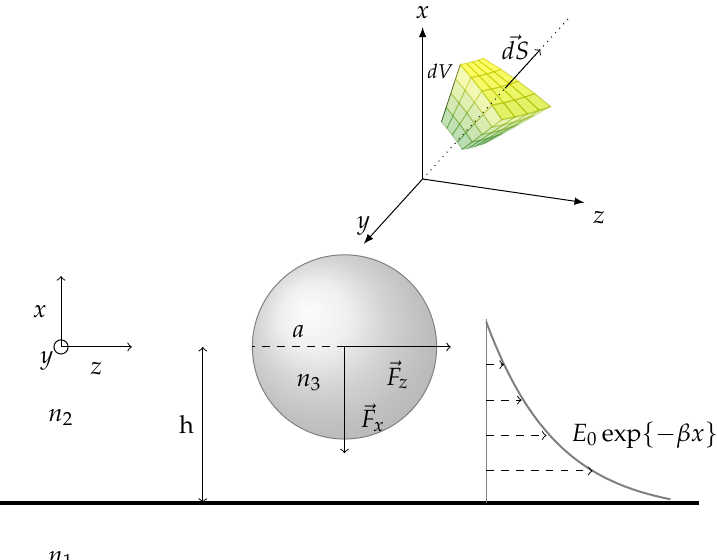
Figure 5. Schematic drawing of a sphere of radius a in the evanescent field of an optical waveguide. (cid:126) f in a charge-free nonmagnetic medium, without electrostriction, can be found as